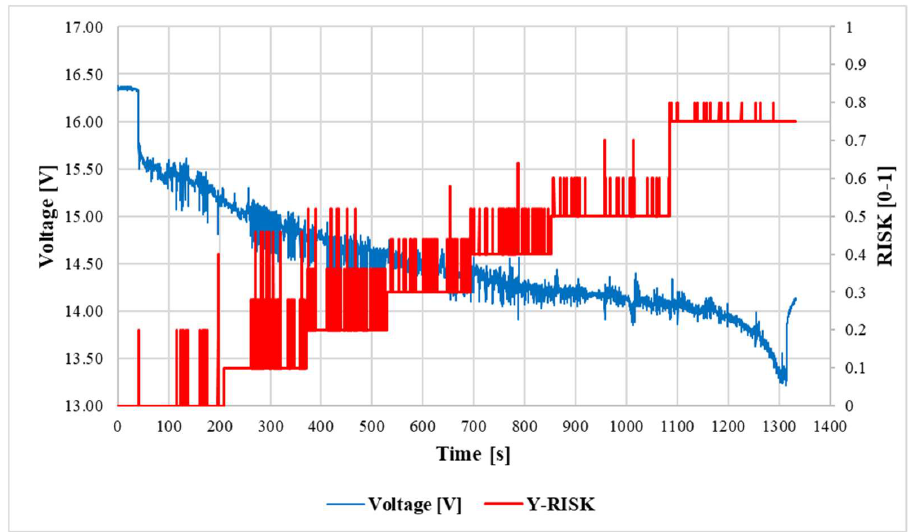
Figure 11. Relationship between the voltage and risk considering the flight time based on real measurements.